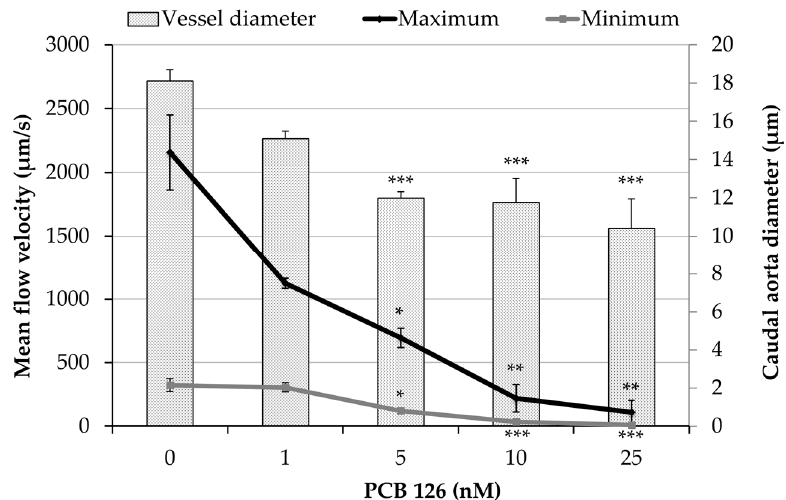
Figure 2. Effects of PCB126 on peripheral blood flow. Maximum and minimum caudal aortic flow velocity after exposure of embryos to PCB126. Vessel diameter plotted on secondary axis. Values are mean ± SEM ( n = 6 larvae). Asterisks represent statistical significance at * p < 0.05, ** p < 0.01, and *** p < 0.001. Table 1. PCB126 exposure decreased peripheral mean blood flow velocity from 1 nM, caused no change in heart rate but significantly decreased cardiac output. The highest concentration tested (50 nM) could not be measured due to the high reduction of blood cells. Values are mean ± SEM on n = 6 larvae. Asterisks represent statistical significance at * p < 0.05, ** p < 0.01, and *** p < 0.001. Maximum Blood Minimum Blood Heart Rate Cardiac Output Treatment Flow (nL/min) Flow (nL/min) (beats/min) (nL/min)